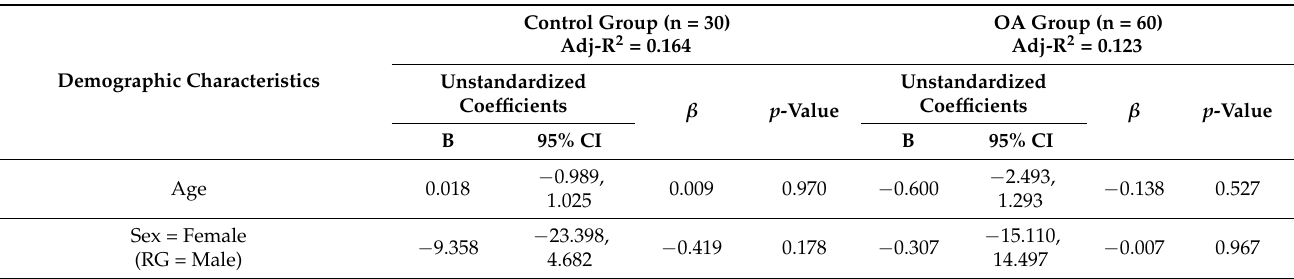
Table 5. Multiple regression analysis between demographic characteristics and mental health component in control and osteoarthritis